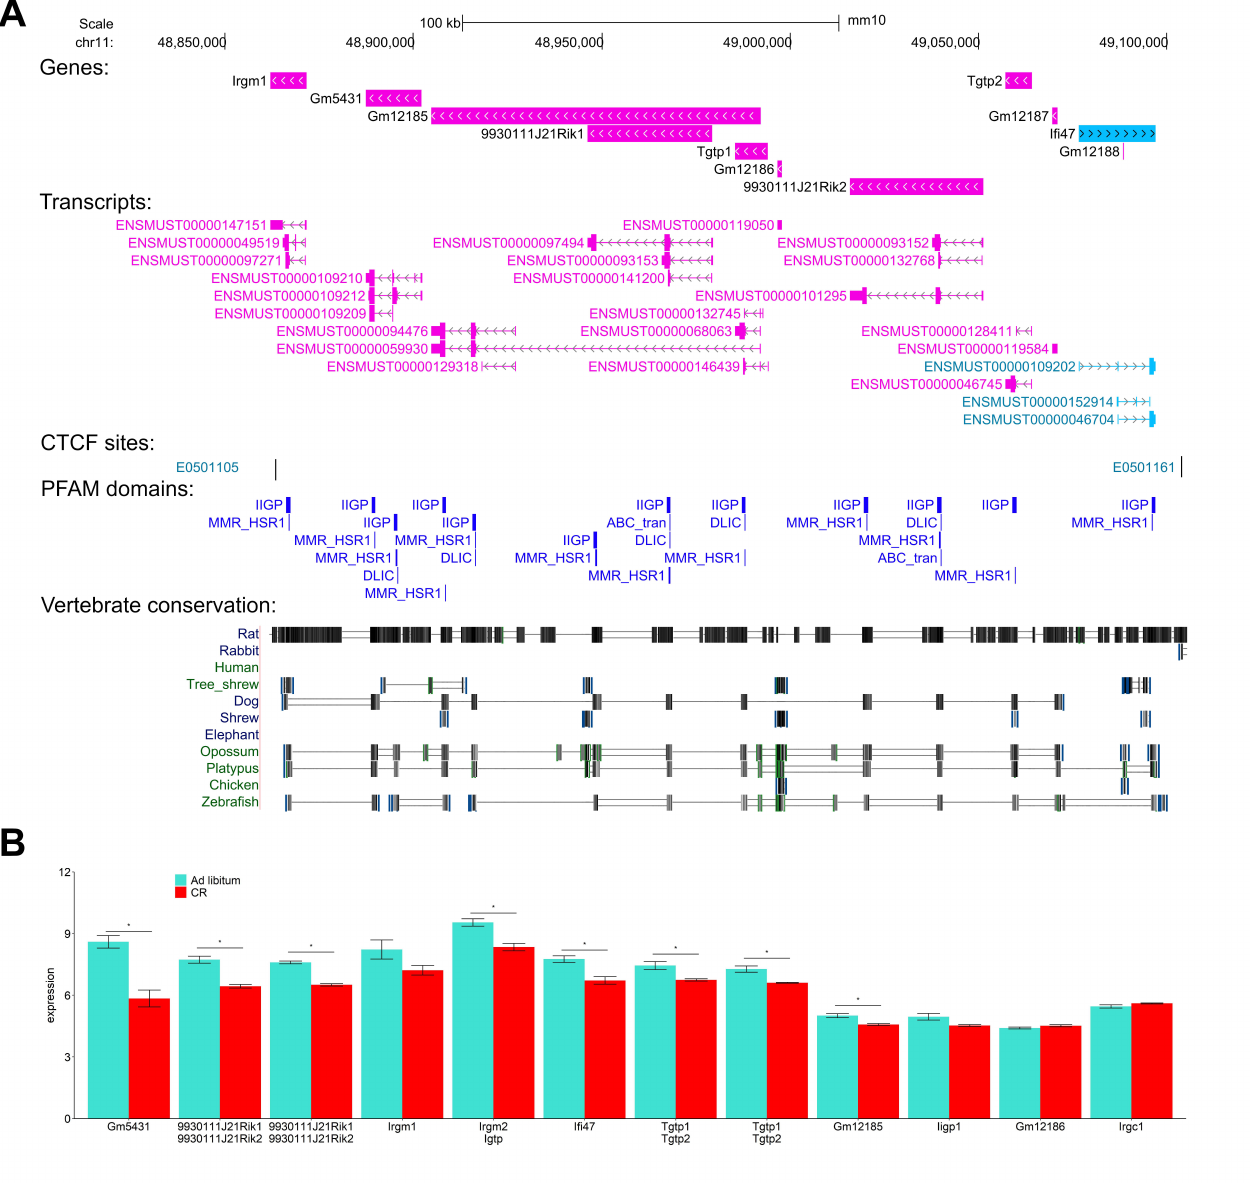
Figure 9. Chr11qB(1.2) locus comprising 10 genes belonging to the CR IFN-induced family. ( A ) Genes and their tran- scribed isoforms are annotated by the latest Ensembl (Build 75) currently supported by the UCSC genome browser (Build 100 annotations in Data S5). All PFAM annotated proteins have one or more conserved functional domains. Pfam-A anno- tates transcript regions within the peptide recognizable as Pfam protein domains in characterized and non-characterized protein-coding genes for mouse assembly mm10 track of UCSC by the software HMMER3: IIGP (Interferon-inducible GTPase; PF05049), MMR_HSR1 (50S ribosome-binding GTPase; PF01926), DLIC (Dynein light intermediate chain; PF05783), ABC_tran (ABC transporter; PF00005). CTCF sites are displayed by the ENCODE Candidate Cis-Regulatory Elements (cCREs) track combined from all cell types. We used the UCSC “Multiz alignments” track, mouse assembly mm10, with multiple alignment data combining PhyloP and PhastCons methods. It shows evolutionary conservation from the PHAST package for 60 vertebrates and three subsets (Glires, Euarchontoglires, placental mammal). ( B ) Data are presented as the mean ± SEM. Asterisks indicate adj. p -values < 0.05 for statistical